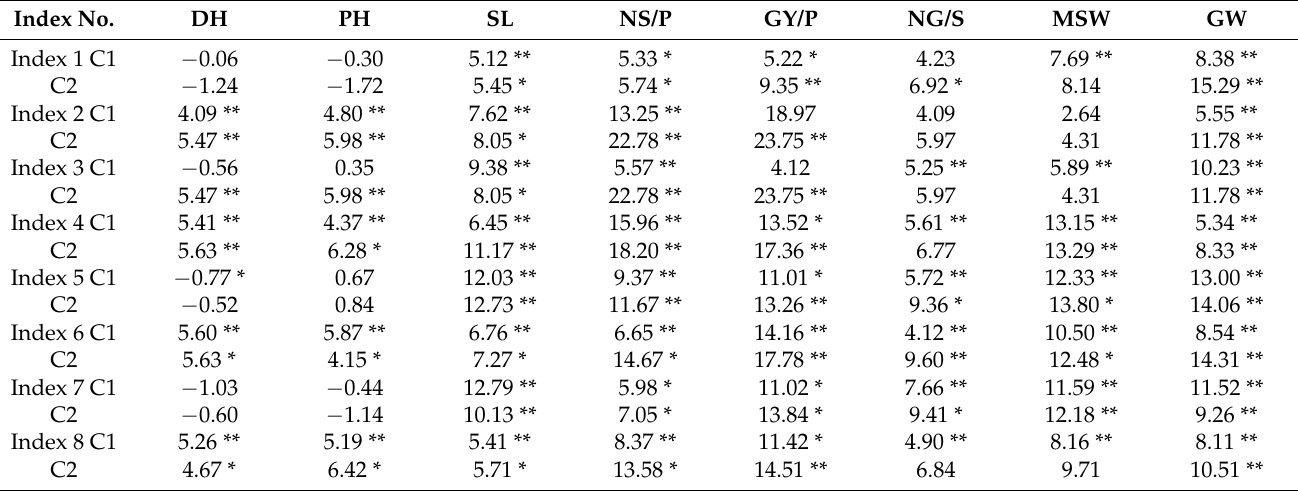
Table 6. The observed direct and correlated genetic gain in percentage of the mid-parent in cycle 1 (C1) and cycle 2 (C2) of